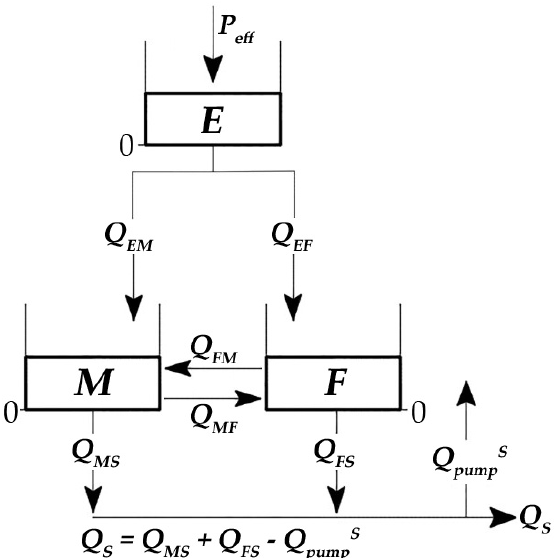
Figure 3. Structure of the KarstMod model platform.